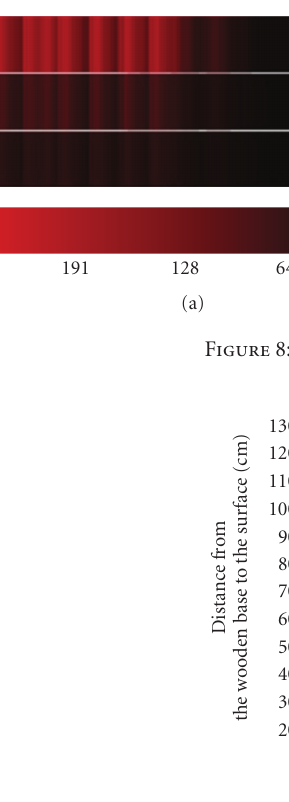
Figure 9: Red intensities seen by the camera at di ff erent distances to the surface using the beam splitter setup.